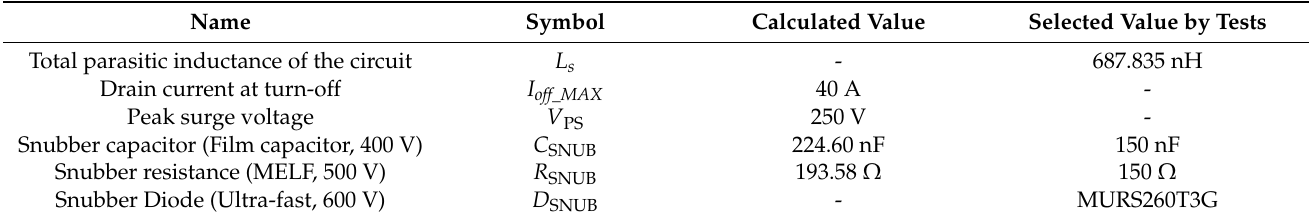
Figure 9. Discharge-suppressing RCD snubber circuit. Table 3. Snubber circuit